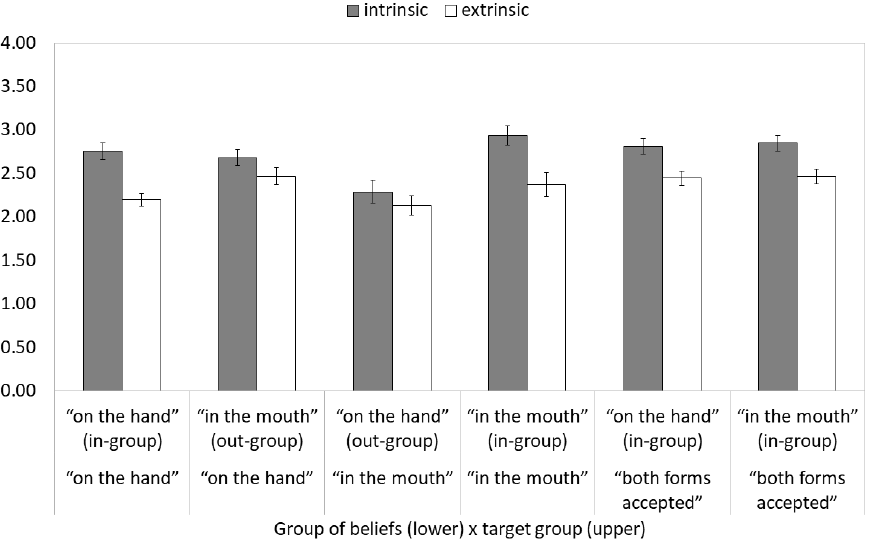
Figure 2. Ascription of intrinsic and extrinsic religious orientations to in-groups and out-groups and beliefs about the proper form of the reception of Holy Communion during the COVID-19 pandemic. The effect of out-group favoritism occurred in the “hand only” group. The “mouth only” group (out-group) was described as more extrinsically oriented ( M = 2.468; SD = 0.823) compared to the in-group ( M = 2.197; SD = 0.621; p = 0.001). In both in-groups and out- groups, the intrinsic religious orientation was estimated as significantly higher than the extrinsic religious orientation ( p < 0.001 and p = 0.043, respectively). Intergroup bias was found in the “mouth only” group. The estimated intrinsic religious orientation to the in-group was significantly higher ( M = 2.935; SD = 0.965) than intrinsic religious orientation ascribed to the out-group (“hand only”; M = 2.289; SD = 0.910; p < 0.001). The estimated ex- trinsic religious orientation to the in-group was marginally significantly higher ( M = 2.374; SD = 0.792) than extrinsic religious orientation ascribed to the out-group (“the hand only”; M = 2.133; SD = 0.755; p = 0.081). Moreover, intrinsic orientation ascribed to the in-group was higher than the ascribed extrinsic orientation to the in-group ( p < 0.001), while